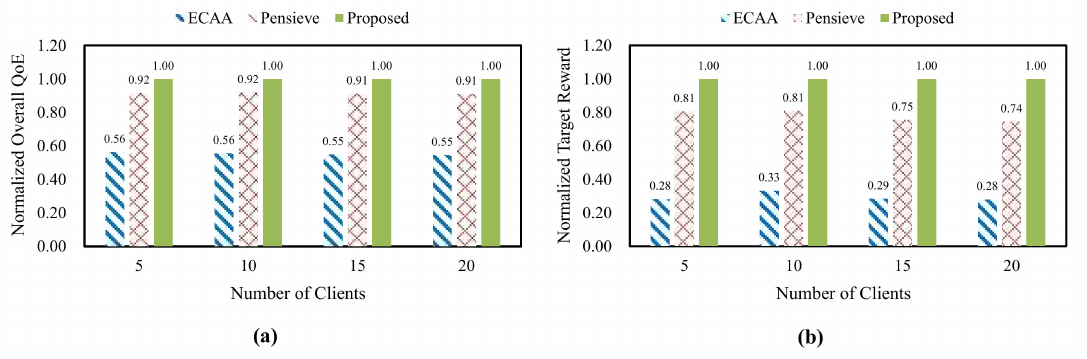
Figure 7. Overall QoE and target reward according to the number of clients, ( a ) normalized overall QoE, ( b ) normalized target